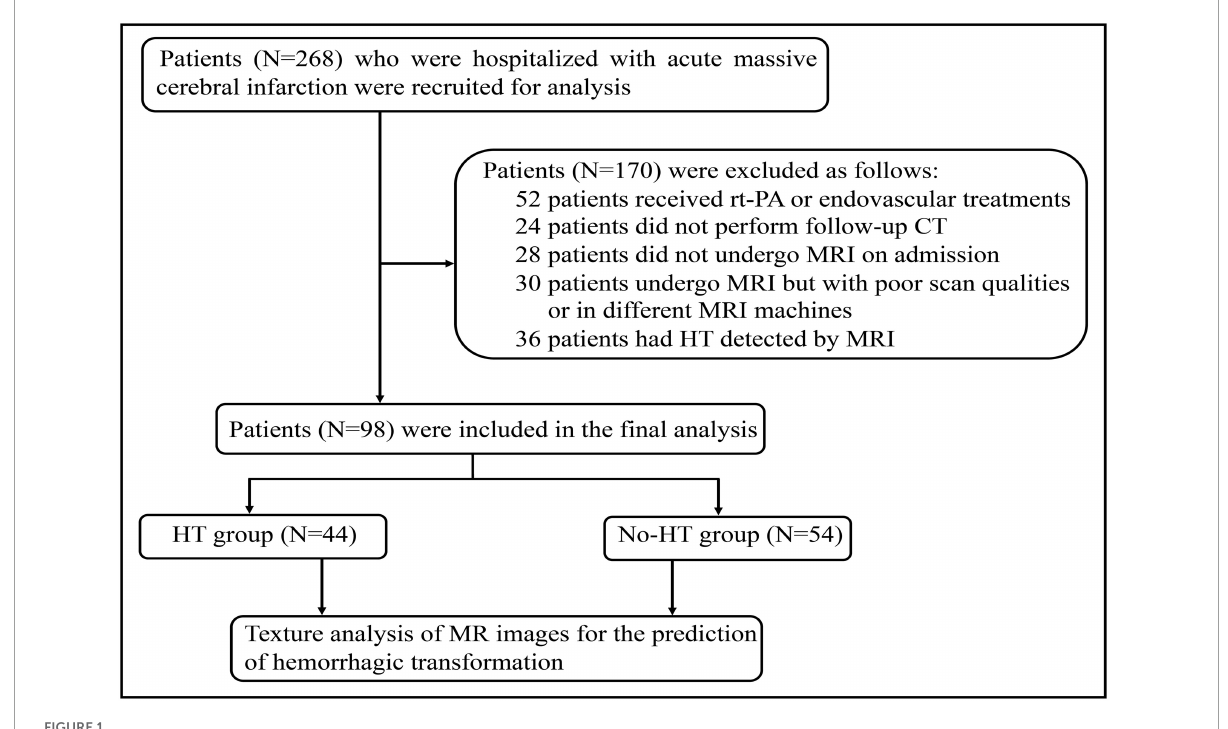
FIGURE1 Flow diagram for patient